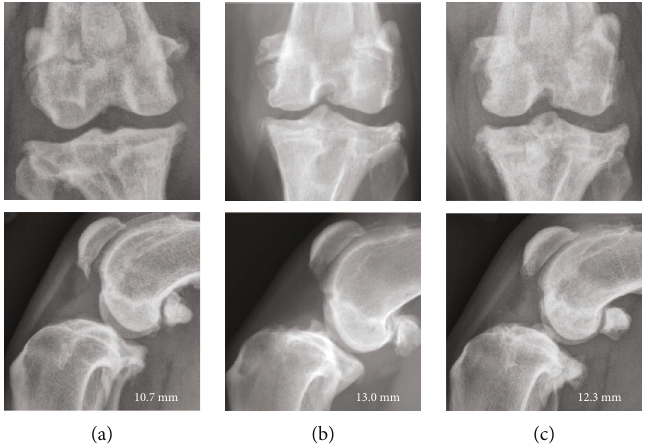
Figure 2: Representative orthogonal radiographic views of sti fl e from a 9-year-old female spayed Boxer mix (a), a 10-year-old female spayed Collie mix (b), and a 9-year-old male neutered Labrador Retriever (c) with severe osteoarthritis and synovial e ff usion in which arthroscopy was used as management for CR. Severity of sti fl e osteoarthritis and synovial e ff usion were graded based on previously published scales [9]. (a) and (b) represent grade 1 synovial e ff usion and grade 3 osteophytosis; (c) represents grade 2 synovial e ff usion and grade 3 osteophytosis. In images (b) and (c), the medial buttress is moderate to severe. The mm of tibial translation is noted in each